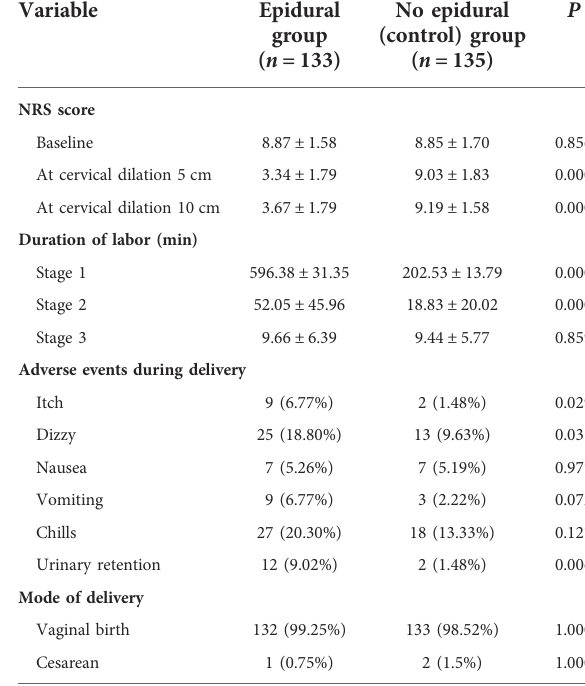
TABLE 2 Perinatal variables of parturients who completed the study.